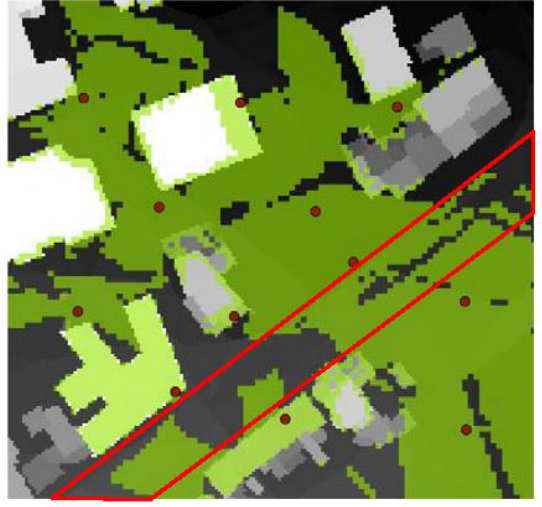
Figure 15. Coverage map of 12 sensors using the local context-aware method, considering the street (Zone 1) as the restricted area without sensors (the red border zone).